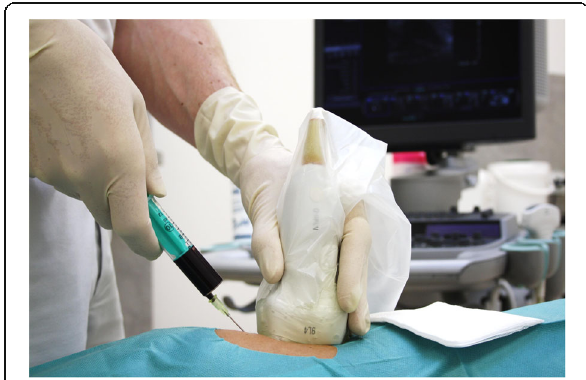
Fig. 5 Ultrasound guided puncture of a haematic lesion in context of a structural muscle injury of the rectus femoris